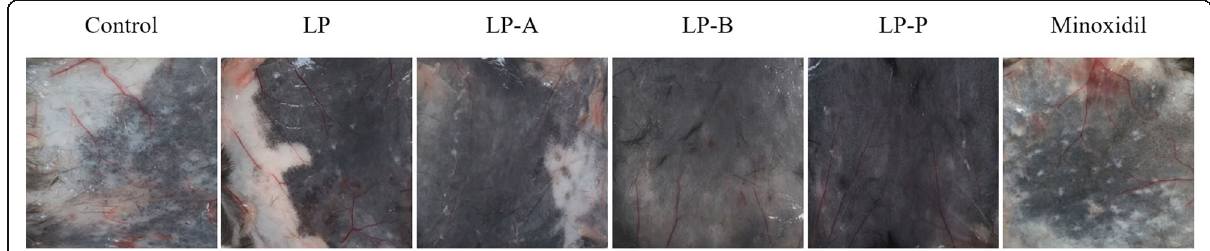
Fig. 6 Hair growth on the reverse side of the skin. After the gray skin color was detected, the skin was isolated and the reverse side was photographed to evaluate dilated blood